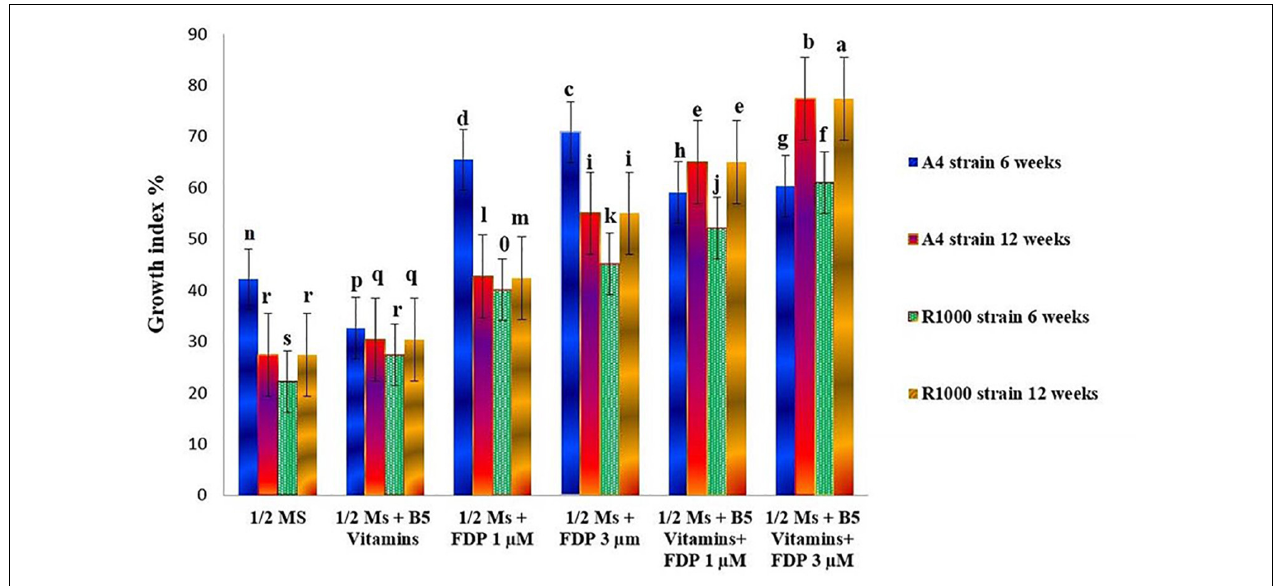
FIGURE 4 | Effect on the mean growth index of A. vulgaris hairy root culture after 6 and 12 weeks (A 4 and R 1000 strains).